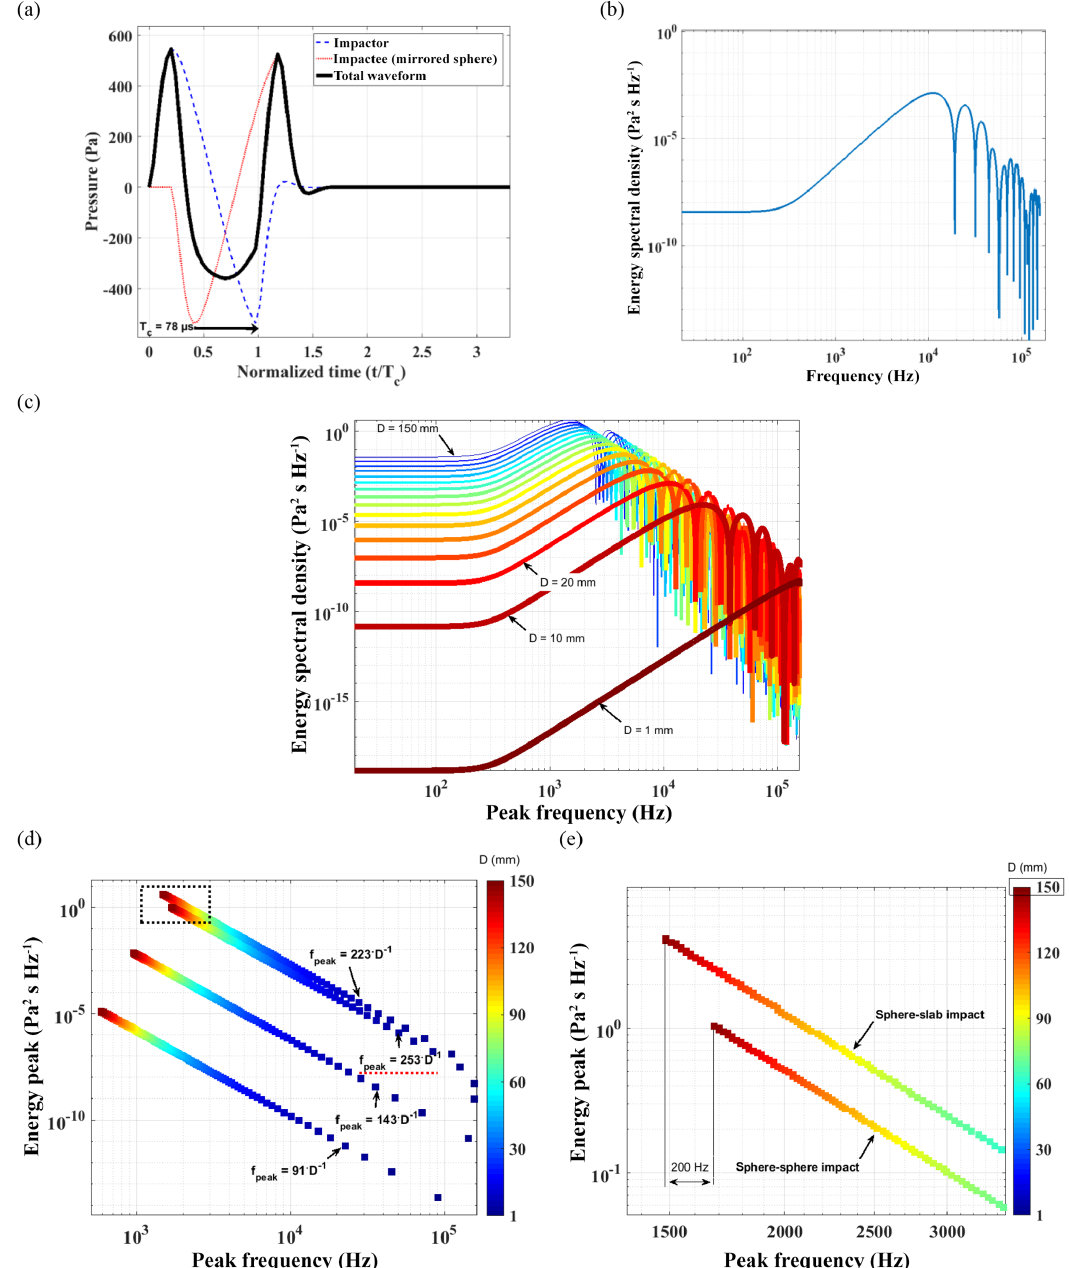
Figure 2. (a) Analytical waveform of sound from impact between a granite sphere of diameter D = 20mm and a granite slab, where the impact velocity U imp = 1ms − 1 , the directivity angle θ = 0 ◦ and the sensor is r = 1m from the impact; the arrow indicates the contact duration T d ; (b) the analytical spectrum modeled with Eq. (7) using the same parameters as in (a) ; the spectrum is an energy spectral density and is measured in Pa 2 sHz − 1 ; (c) analytical spectra of sphere–slab impacts modeled by Eq. (7) as a function of diameter, D = { 1 , 10 , 20 , 30 ... 150 } mm; impact velocity U = 1ms − 1 , the directivity angle θ = 0 ◦ and the sensor is r = 1m from the impact. (d) Peak imp frequency f peak and power peak variations, from spectra modeled by Eq. (7), with the diameter and the sphere’s diameters; the diameters are coded by colors. The power law f peak = aD b is given, where the sphere–slab impact tests consider three impact velocities ( U imp = { 0 . 01 , 0 . 1 , 1 } ms − 1 ) and the law of sphere–sphere impact is underlined by the dotted line; the material is granite. From bottom to top, the regression laws of sphere–slab impact vary from U imp = 0 . 01 (bottom) to U imp = 1 (top) ms − 1 . The sphere–sphere impact tests are done using U imp = 1ms − 1 and the same other parameters as with sphere–slab impacts. (e) Detail where the two vertical dotted lines locate the f peak of the impact spectrum from 150mm diameter particles for both impact